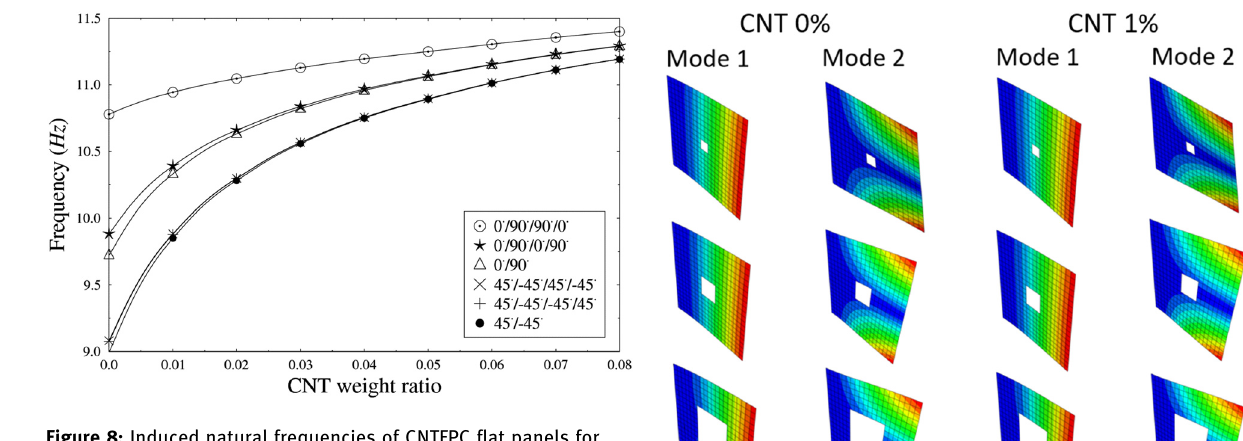
Figure 8: Induced natural frequencies of CNTFPC fl at panels for di ff erent SWCNT weight ratios and layup sequences.